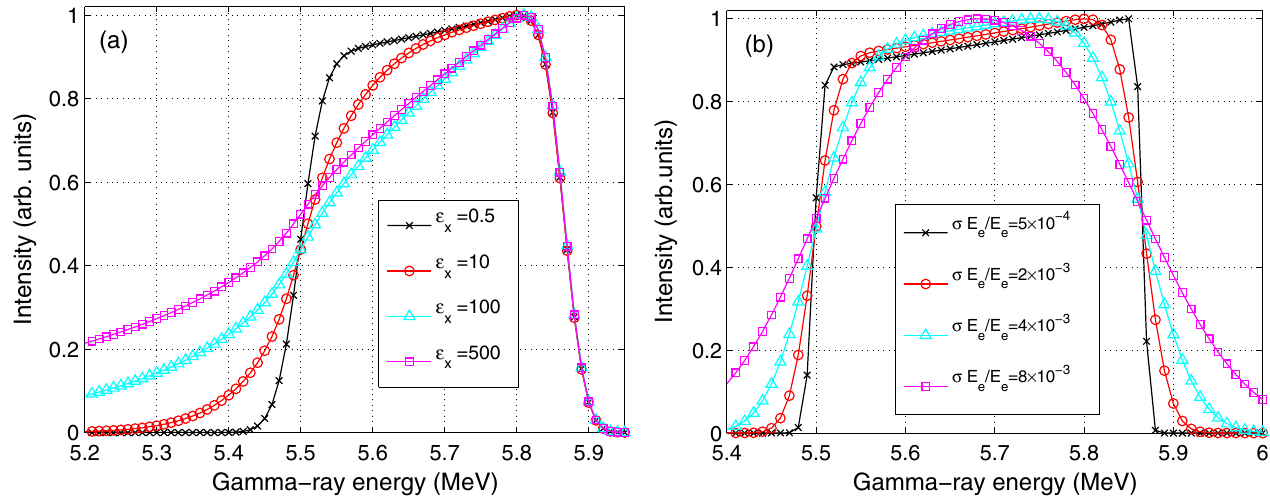
FIG. 4. (Color) Calculated energy spectra of gamma beams produced by Compton scattering of a 800 nm laser beam with a 500 MeV electron beam for different horizontal emittances " aperture with radius of 16 mm which is placed 60 m downstream from the collision point. The spectra are scaled to their respective peak values. (a) The horizontal emittance " fixed at 2 (cid:1) 10 (cid:2) 3 . (b) The relative energy spread (cid:5) fixed at 0.05 nm